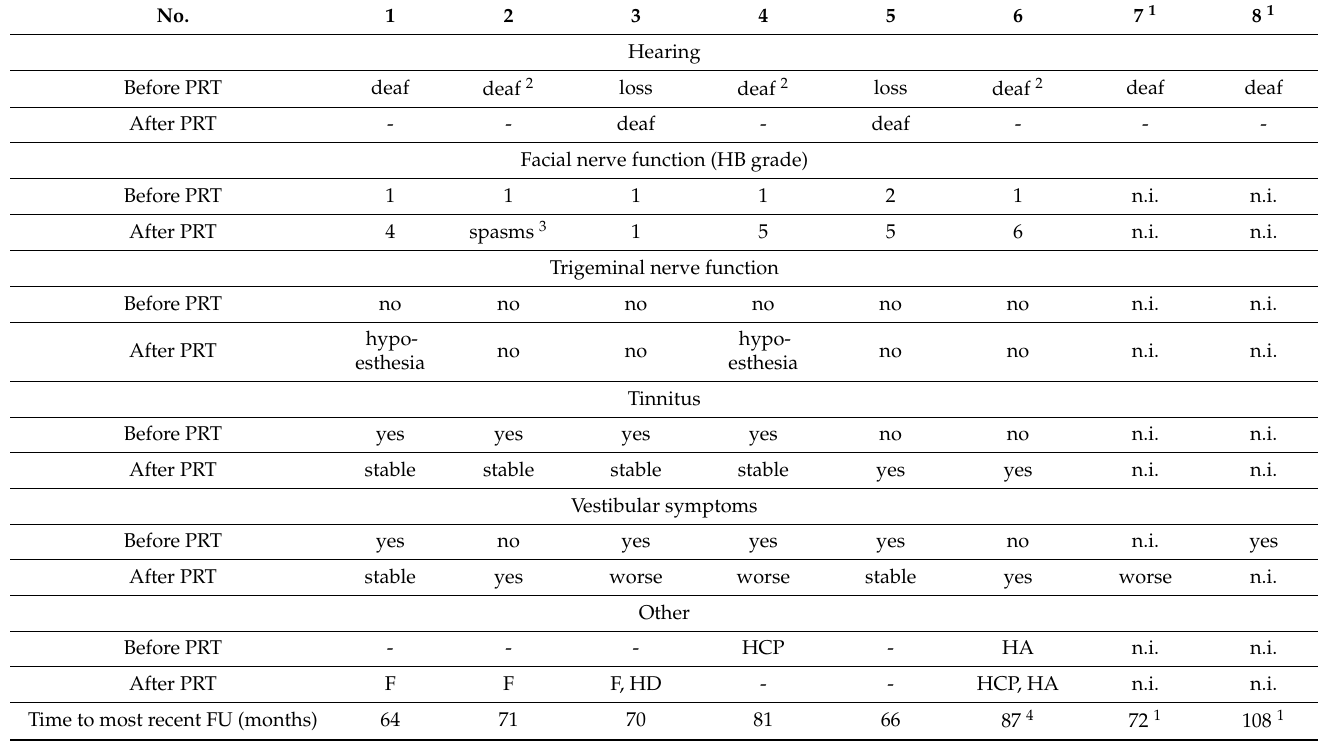
Table 4. The presence of symptoms and/or treatment-related toxicity during the clinical